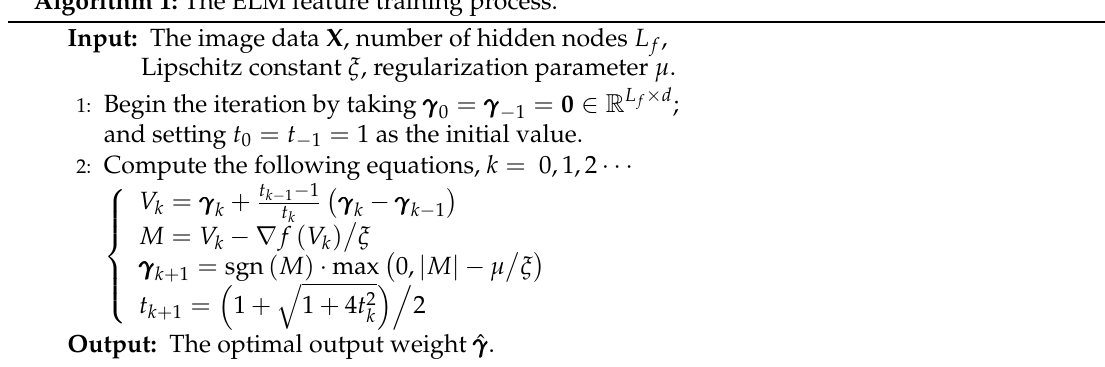
Algorithm 1: The ELM feature training